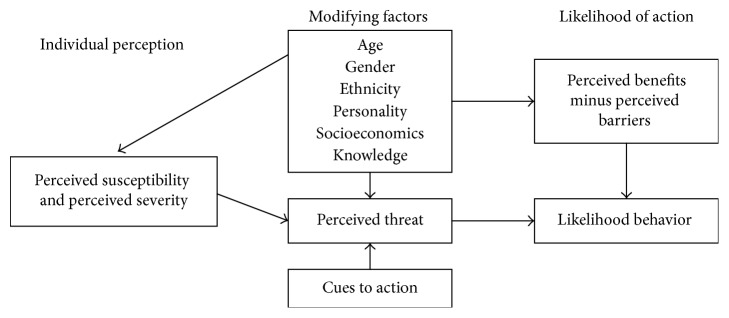
Health Belief Model theory components and linkages.